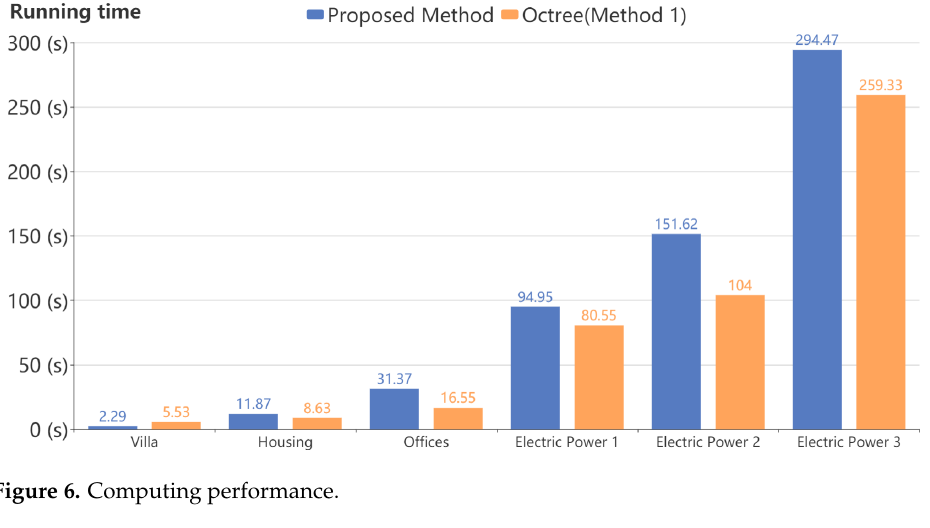
Figure 6. Computing performance.